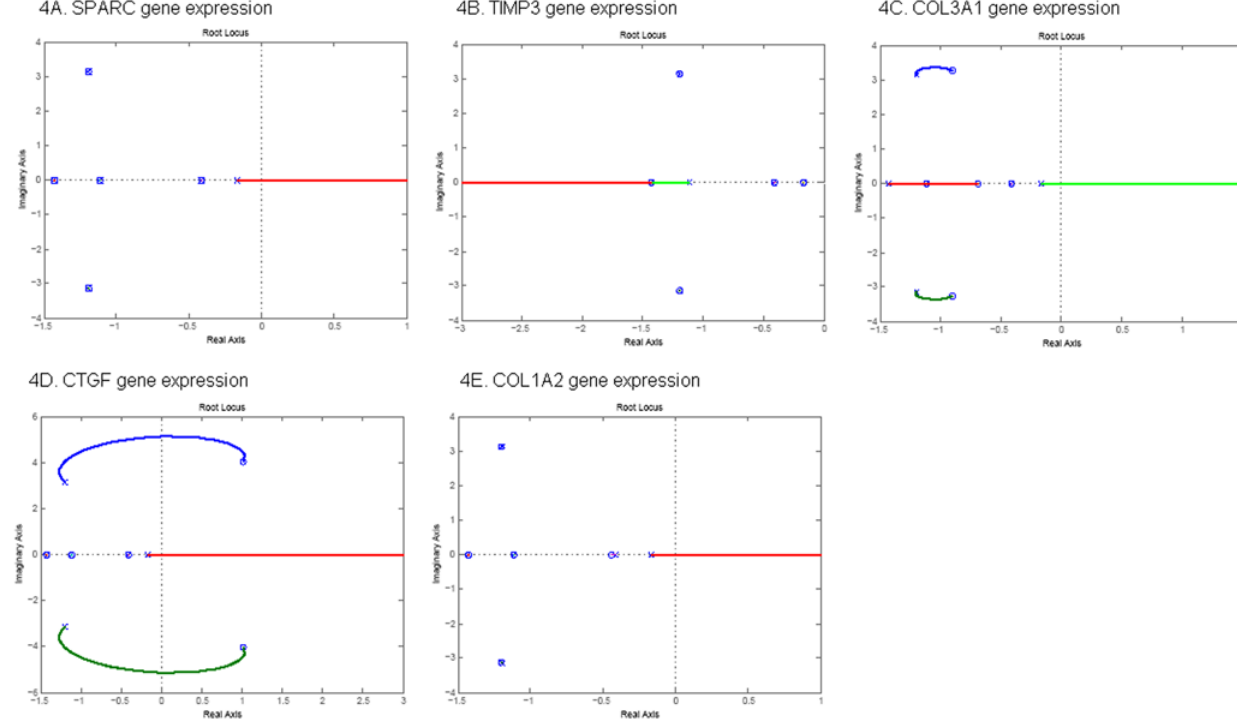
Figure 4. Root-locus of gene expression in normal fibroblasts.